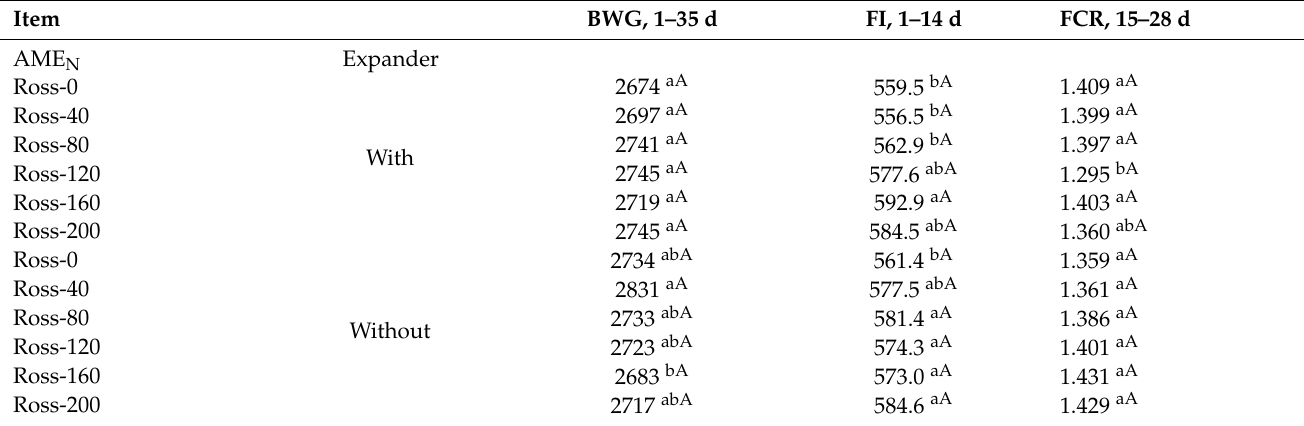
Table 10. Breakdown of significant interactions as presented in Table